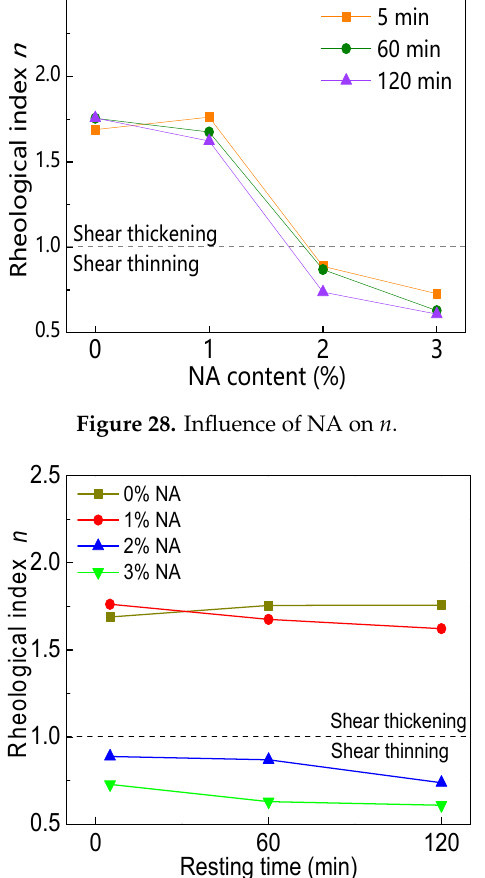
Figure 29. Influence of resting time on n.